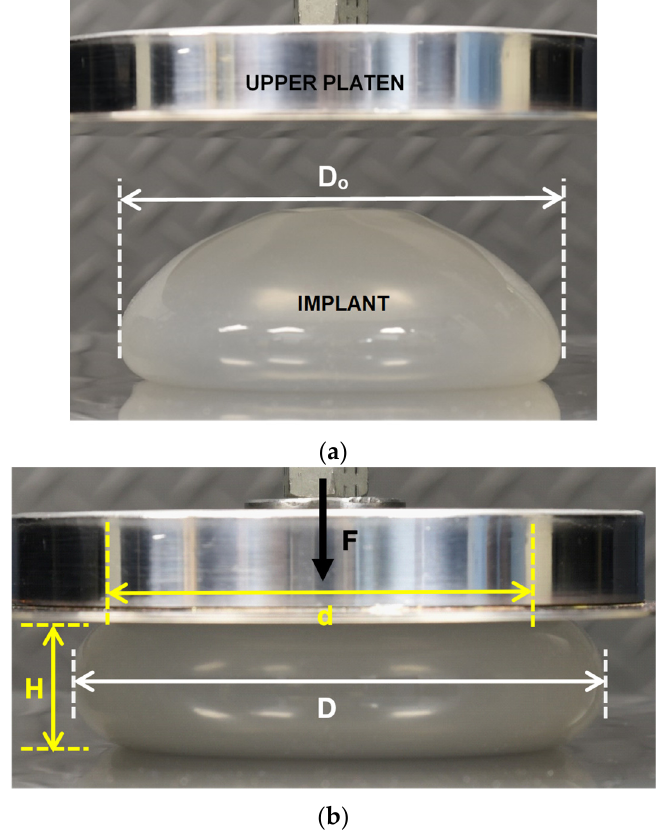
Figure 2. ( a ) IDEAL IMPLANT between Platens Prior to Compression Testing. ( b ) IDEAL IMPLANT Undergoing Compression (44.5 N) with Labelled Geometric Properties.